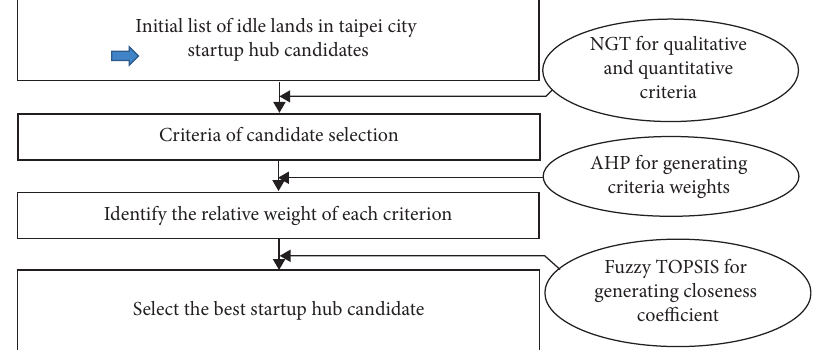
Figure 1: The integration process of site selection across a number of startup hub